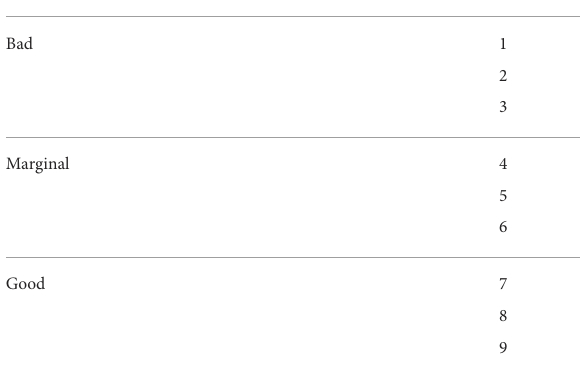
TABLE 1 NAME scoring system.